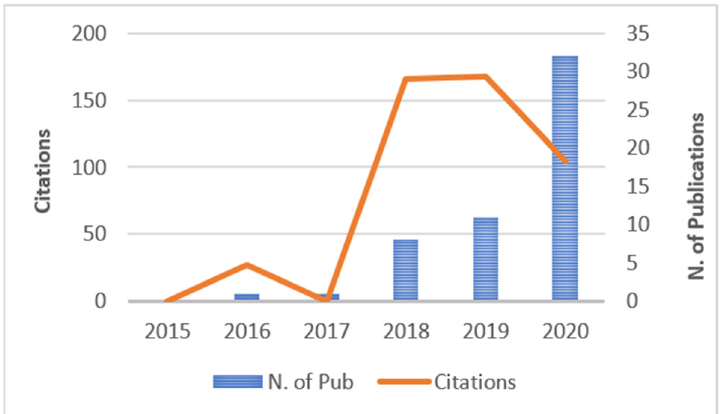
Figure 4. Number of publications/citations per year.